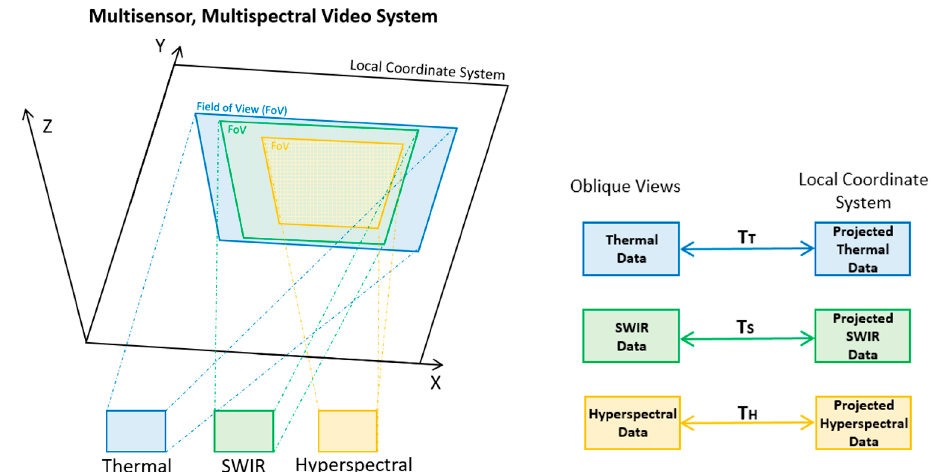
Figure 4. The multisensor system observes the region of interest (ROI), while each sensor has different field of views (FOVs). The ROI plane is associated with an arbitrarily defined, local coordinate system (LCS). In order to establish correspondences among the different FOVs, the perspective and inverse perspective transformations are estimated which can relate image coordinates among the different oblique views of all imaging sources.